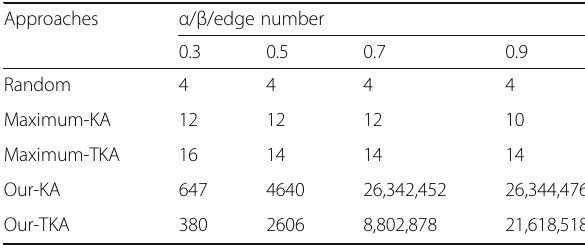
Table 1 The different parameters are employed in the weighted similarity function WCN, and λ = 0.3 to obtain the edge number values Approaches α / β /edge